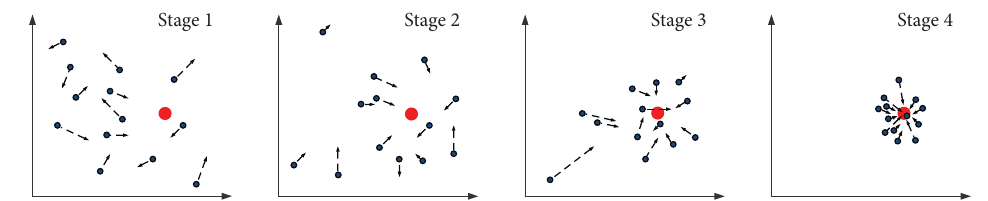
Figure 5: Particle’s arrangement in the PSO in four different progressive iteration instants. The red circle indicates the global optimum